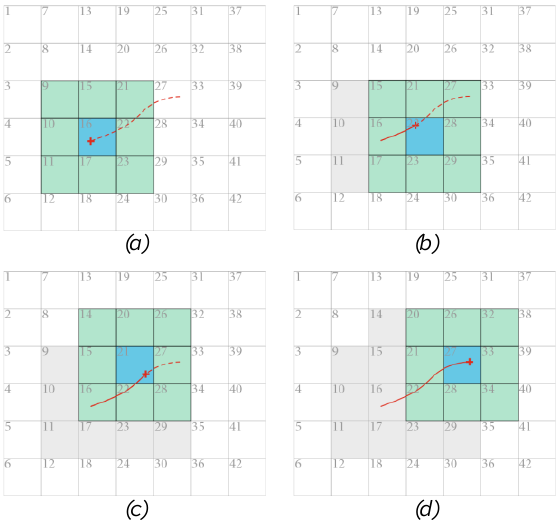
Figure 5. Principle of mosaic memory management. Images (a) to (d): successive radar positions. Red line indicates radar trajectory. Blue and green squares show the position of the 3×3 local map. When radar moves, the position of the local map is adapted. For example in (b), square labelled 22 becomes the central square of the local map: squares labelled 9-10-11 are stored in bulk memory; squares 27-28-29 are recovered from the bulk memory (if they exist) or created as empty squares, in order to obtain an operational configuration of the local